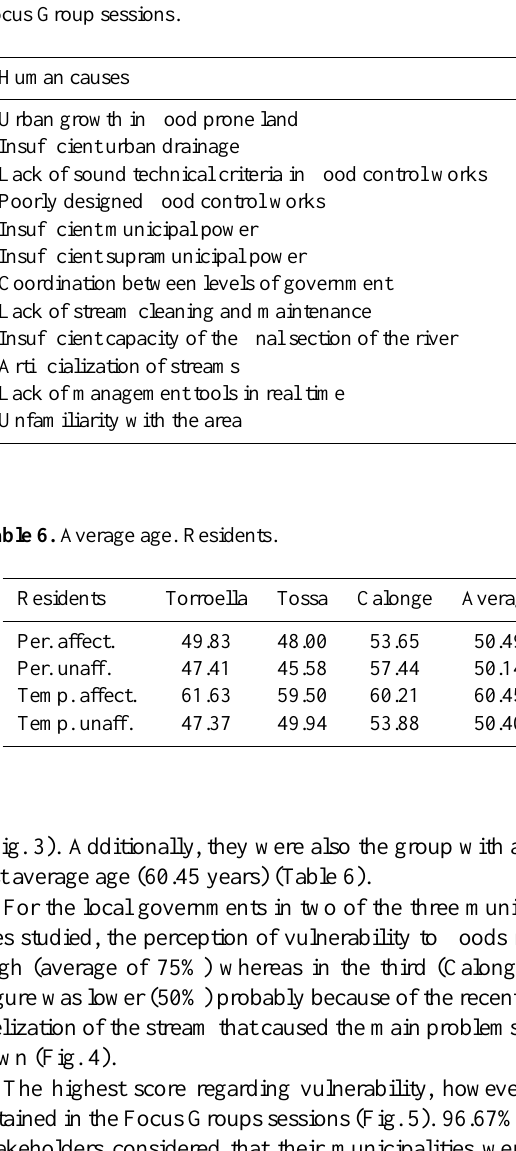
Table 5. Human causes of the flood problem. Social sectors in Focus Group sessions.